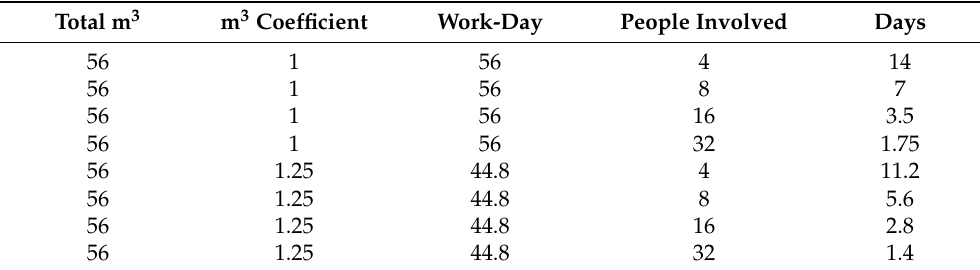
Table 1. Estimation of the amount of labour involved in building the burial mound feature 8 according to 1 and 1.25 m 3 working day coefficients and to different possible groups of people involved. Total m 3 m 3 Coefficient Work-Day People